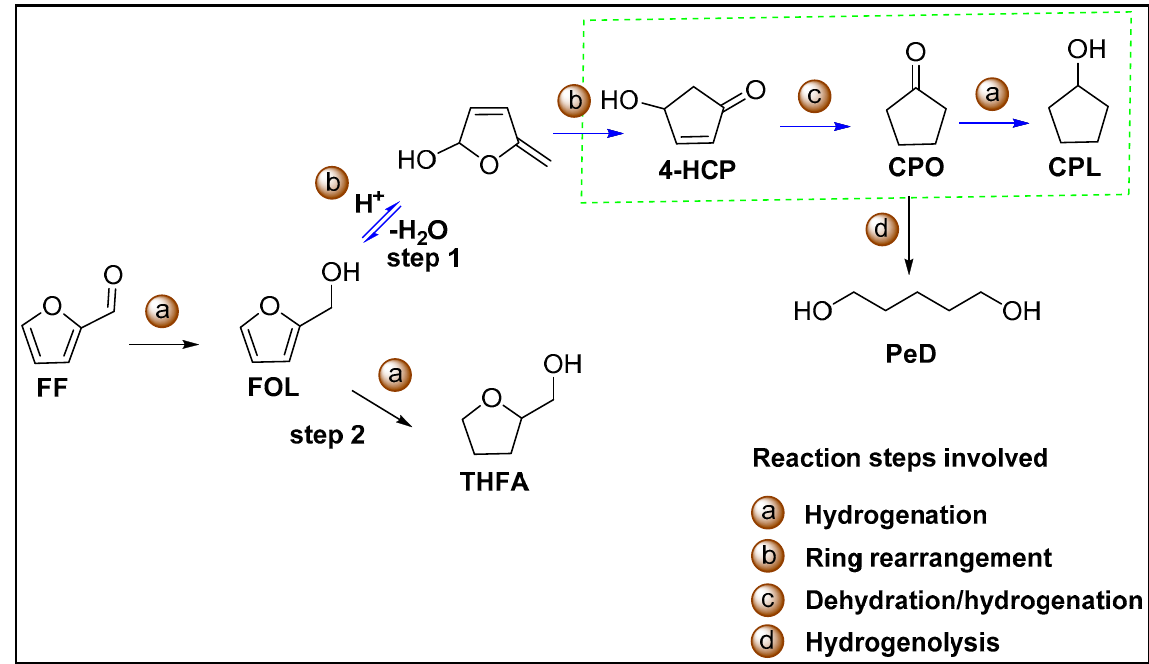
Scheme 1. Possible reaction pathway of hydrogenation of FAL to CPO over various Ni and Cu supported on m − SiO 2 .